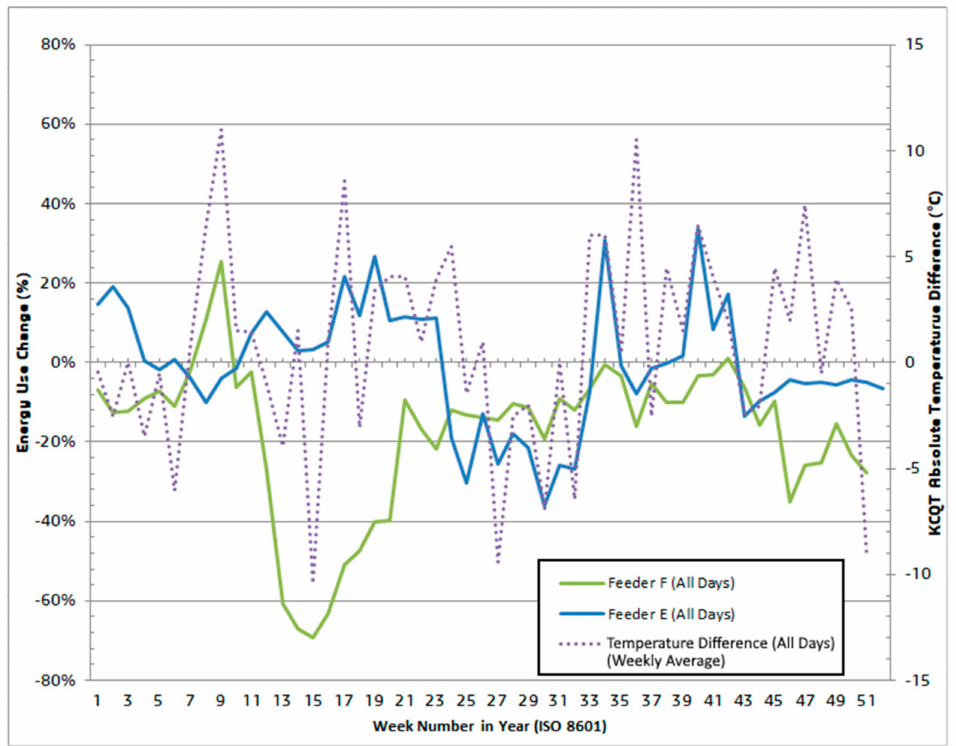
Figure 10. Direct change in energy use (non-normalized for temperature) for Feeder E (large apart- ment complex) and Feeder F (commercial